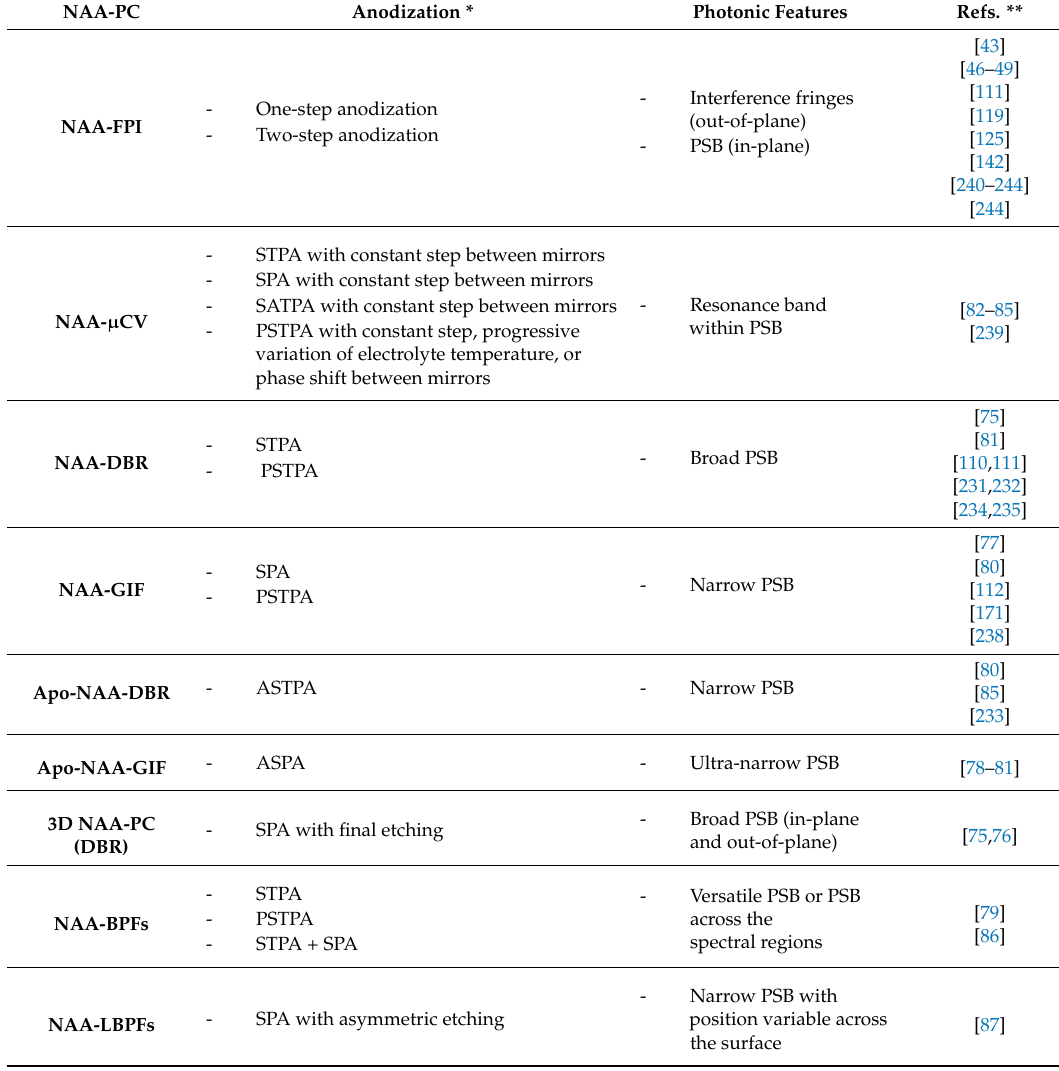
Table 2. Characteristics and optical properties of representative